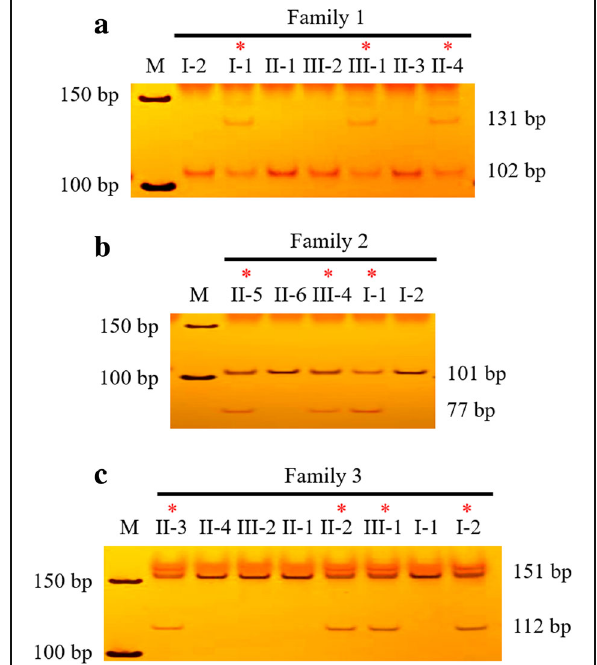
Fig. 4 Neutral polyacrylamide gel electrophoresis ( PAGE) of DNA samples from all study participants in Families 1 – 3. A 50-bp DNA Ladder was used as a marker (lane M). Red asterisks denote affected individuals. The numbers on the left and right of the figures represent the size of markers and DNA fragments, respectively. a : Neutral PAGE of DNA samples from participants in Family 1. The wild-type allele had a Taq α I restriction site, and was therefore digested into 29-bp (not shown) and 102-bp fragments; b : Neutral PAGE of DNA samples from participants in Family 2. The mutation c.4802delT resulted in a gain of the Alu I restriction site after the forward primer ( NF1 -family 2F; Additional file 1: Table S1) introduced a mismatch nucleotide in its 3 ′ end, and the mutant allele was subsequently digested into 24-bp (not shown) and 77-bp fragments; c : Neutral PAGE of DNA samples from participants in Family 3. The mutant allele was digested into 39-bp (not shown) and 112-bp fragments by Sac II since the deletion of